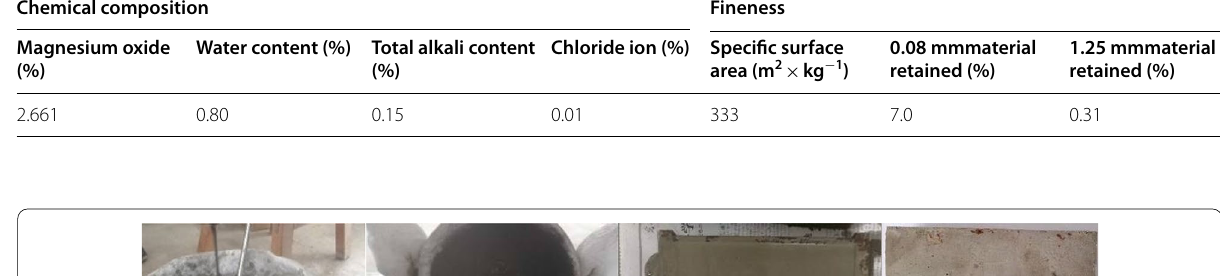
Table 4 Basic properties of the expansion agent Chemical composition